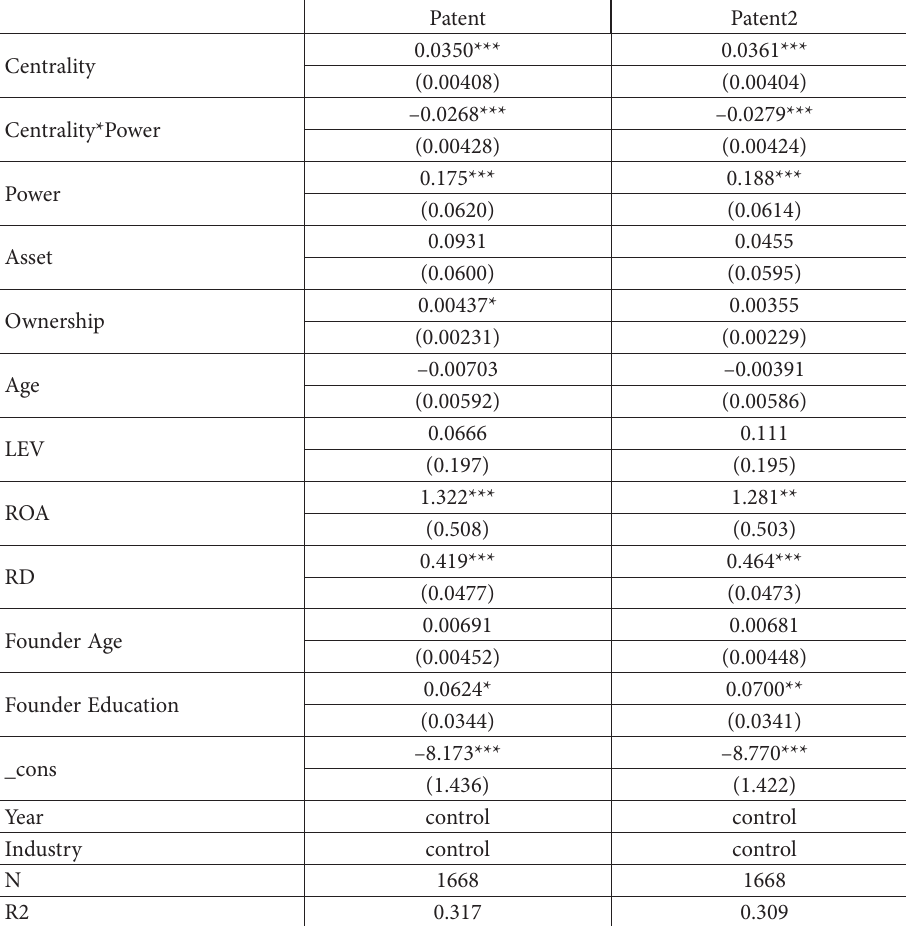
Table 7. The moderating effect of founders’